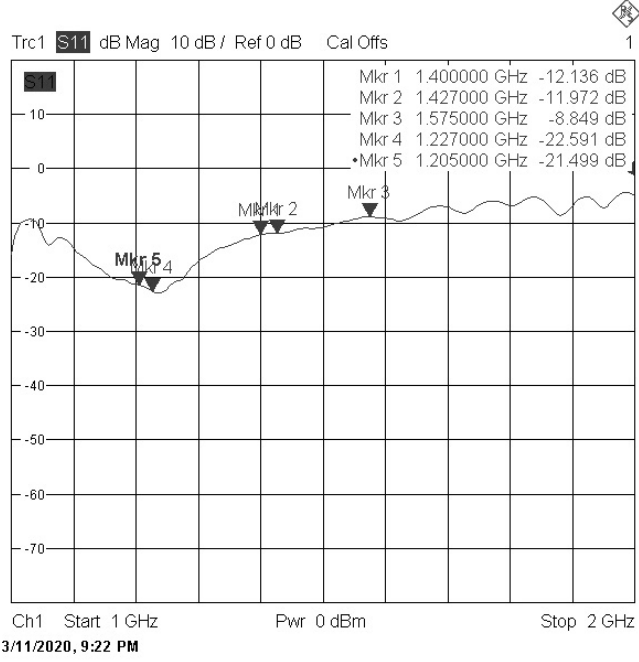
Figure 13. S11 parameters results for the NADS FM.